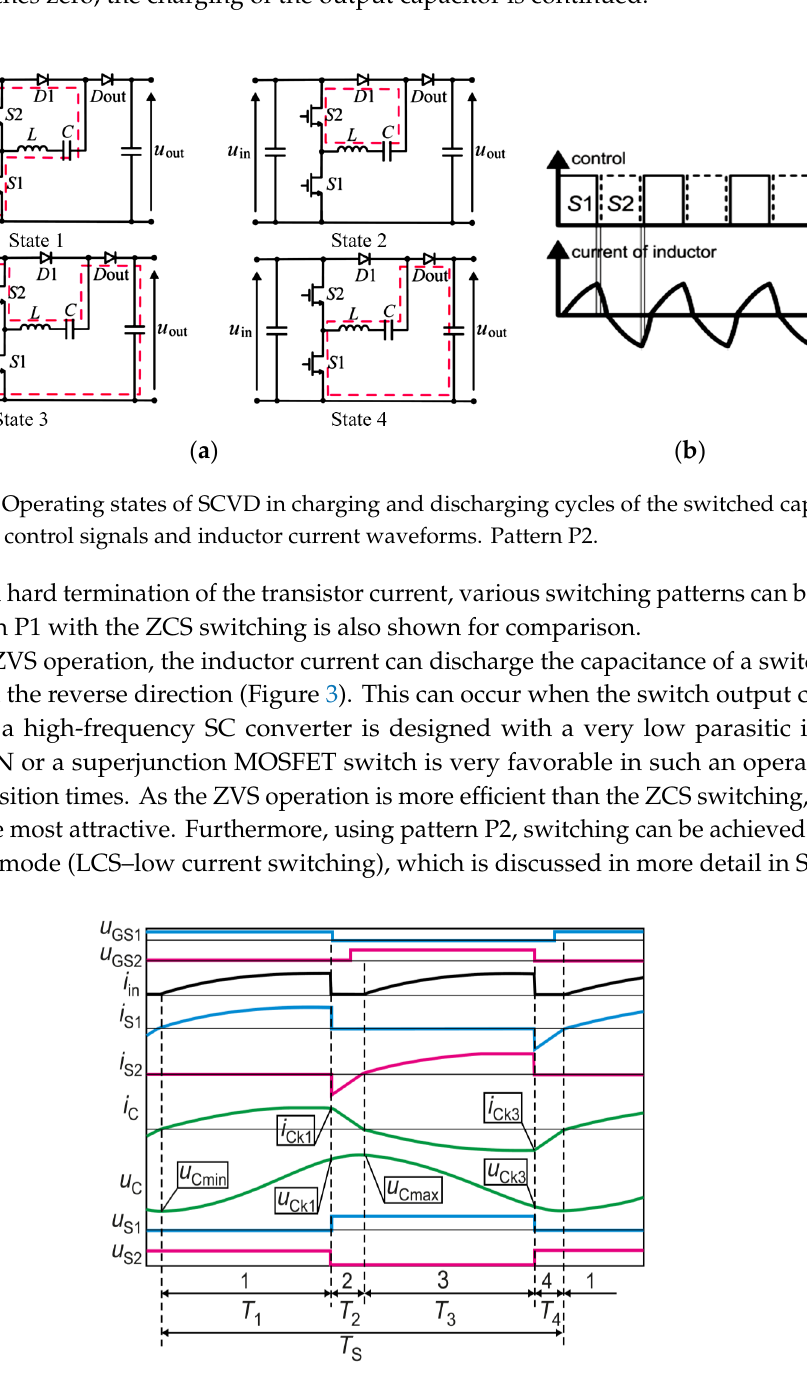
Figure 3. Theoretical time waveforms of currents and voltages in SCVD useful for the analysis – switching pattern P2.